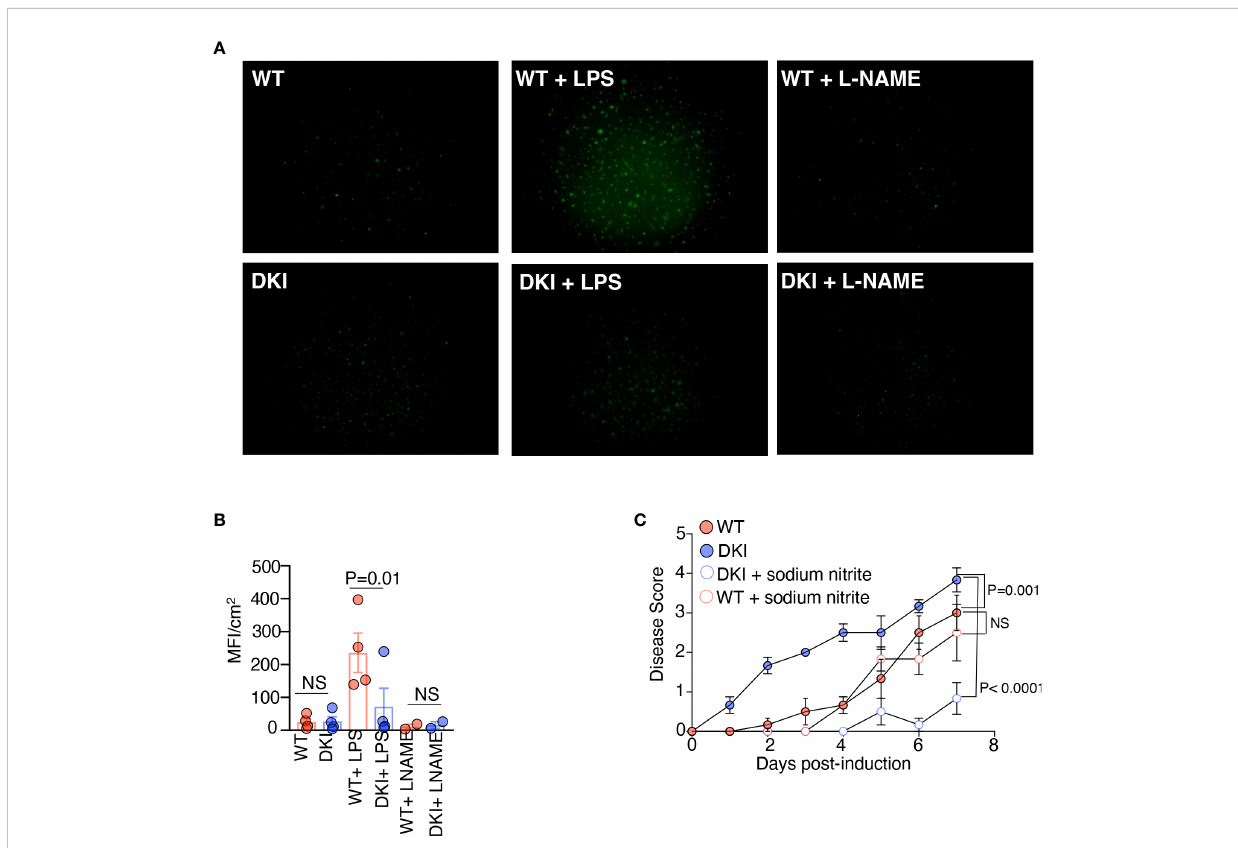
FIGURE 6 Overexpression of Arginase I in DKI Monocytes Limits the Production of Protective Nitric Oxide. (A, B) WT and DKI bone marrow monocytes were differentiated with GM-CSF for 8 d. Some MDCs were stimulated with either LPS or L-NAME for 16h. Cells were stained with DAF-FM diacetate for 30 min. (A) Representative images and (B) Quanti fi cation of data generated from 3 independent experiments. (C) WT and DKI mice were given drinking water containing 1% DSS or 1% DSS with 1 mM sodium nitrite for 7 days. Disease scores are shown. Data are from 2 independent experiments with n=6. (B, C) Data shown are mean ± SEM. Statistical signi fi cance is indicated by the P-value with NS meaning no statistical signi fi cance. (B) Paired t test. (C) Area under the curve with one way ANOVA and Tukey ’ s test for multiple